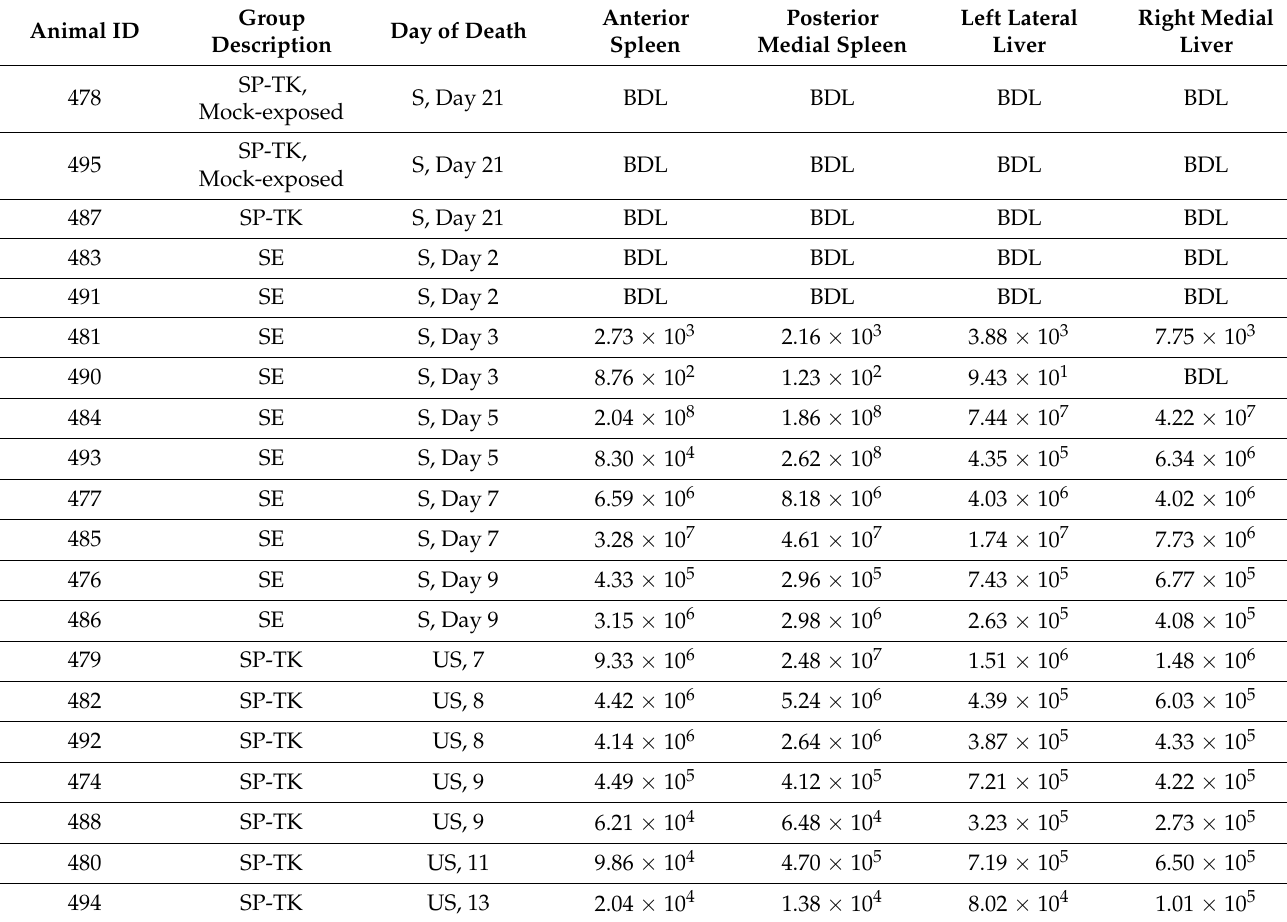
Table 3. Viral Load in Spleen and Liver as Determined by Plaque Assay (PFU/g).